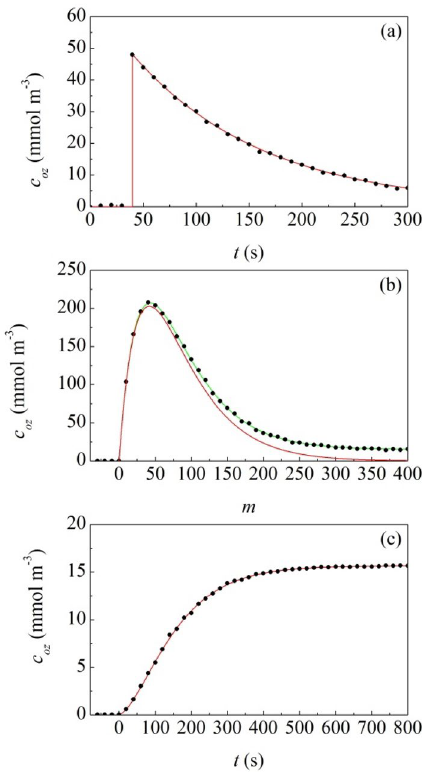
Figure 3. ( a ) Measured O 3 concentration, c oz ( t ) , as a function of time, t . Data refer to experiments in which coarse granite powder is subjected to single impacts. ( b ) Measured O 3 concentration, c oz ( t ) , as a function of the number of impacts, m . Data refer to experiments in which coarse granite powder is subjected to prolonged mechanical processing. ( c ) Measured O 3 concentration, c oz ( t ) , as a function of time, t . Data refer to experiments involving powder particles, whereas the green curve takes into account the frictional